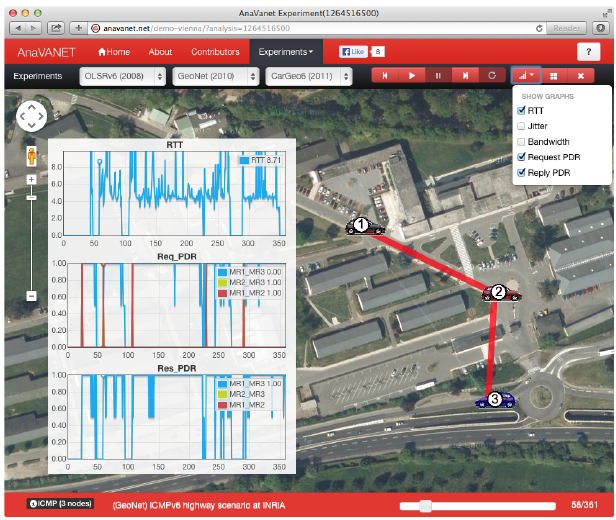
Figure 1. Screenshot of AnaVANET